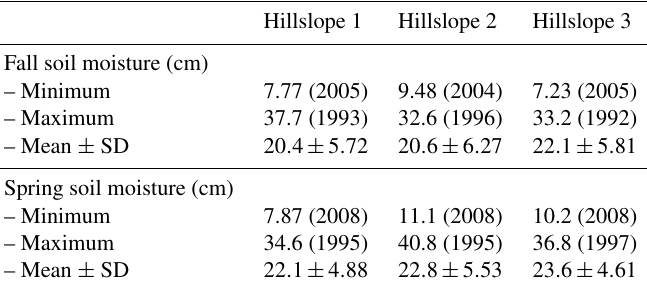
Table 6. Summary statistics of soil moisture data (for simplicity, data are aggregated over the five depth intervals and presented for the entire 0–120cm soil profile; however, data are recorded separately by the depth interval in the